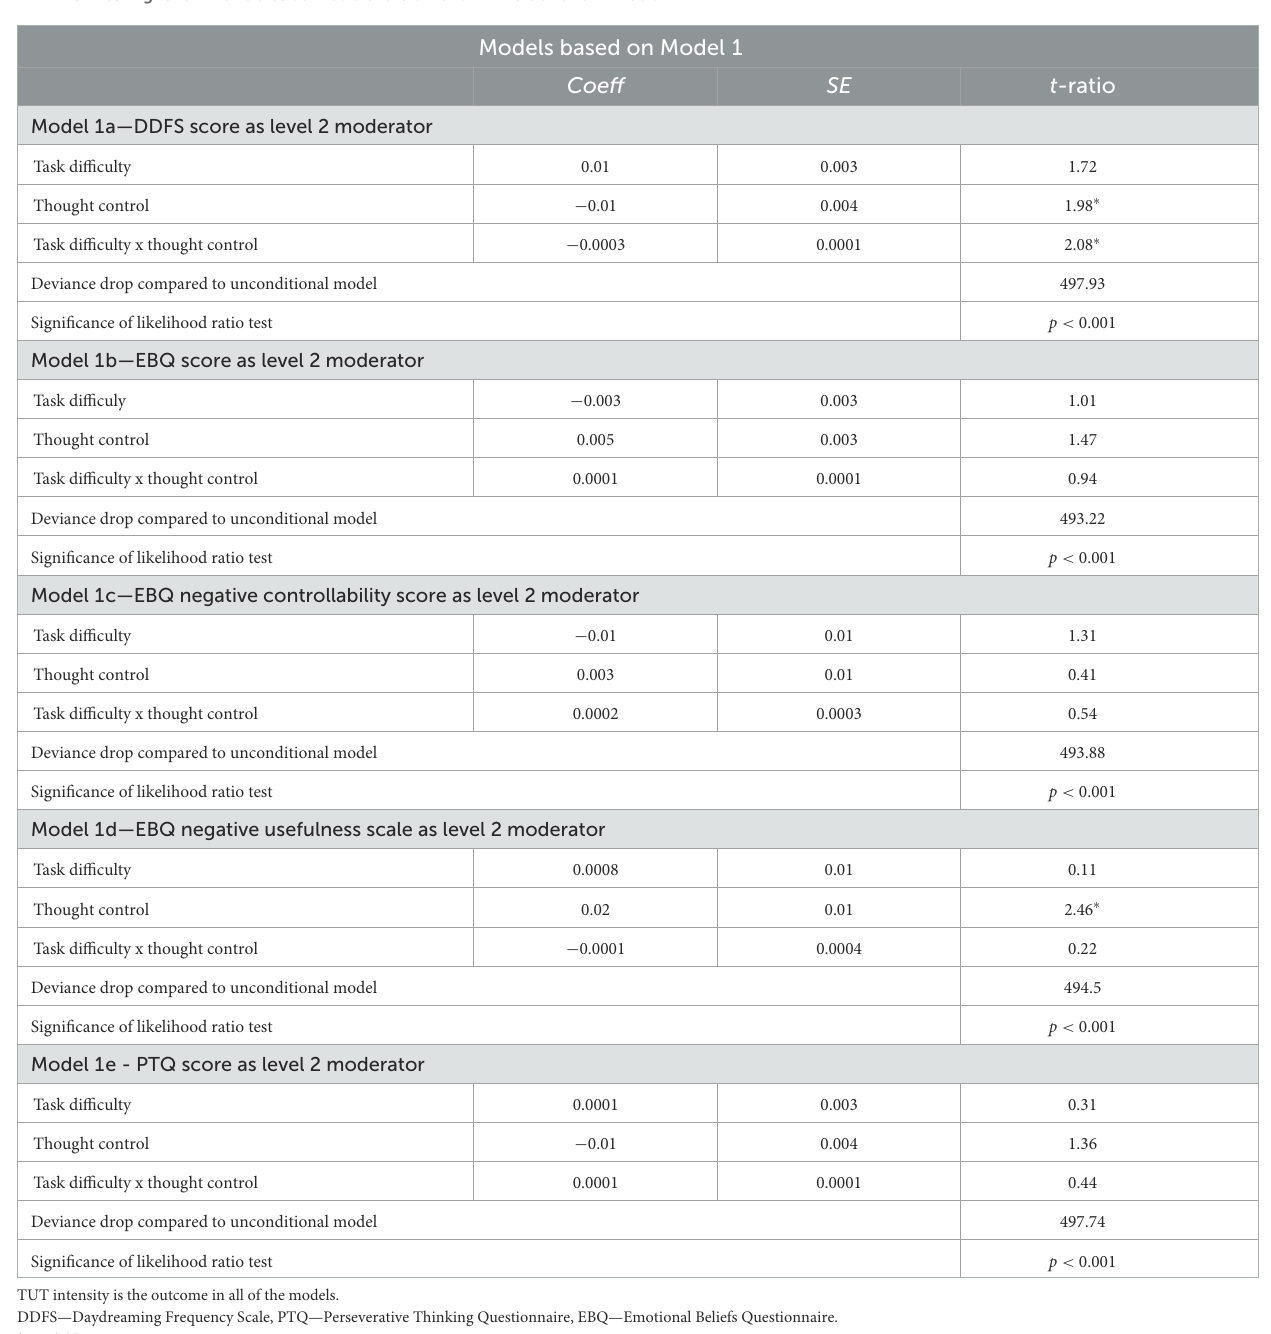
TABLE 3 Testing level 2 variables as moderators of level 1 interactions in Model 1. Models based on Model